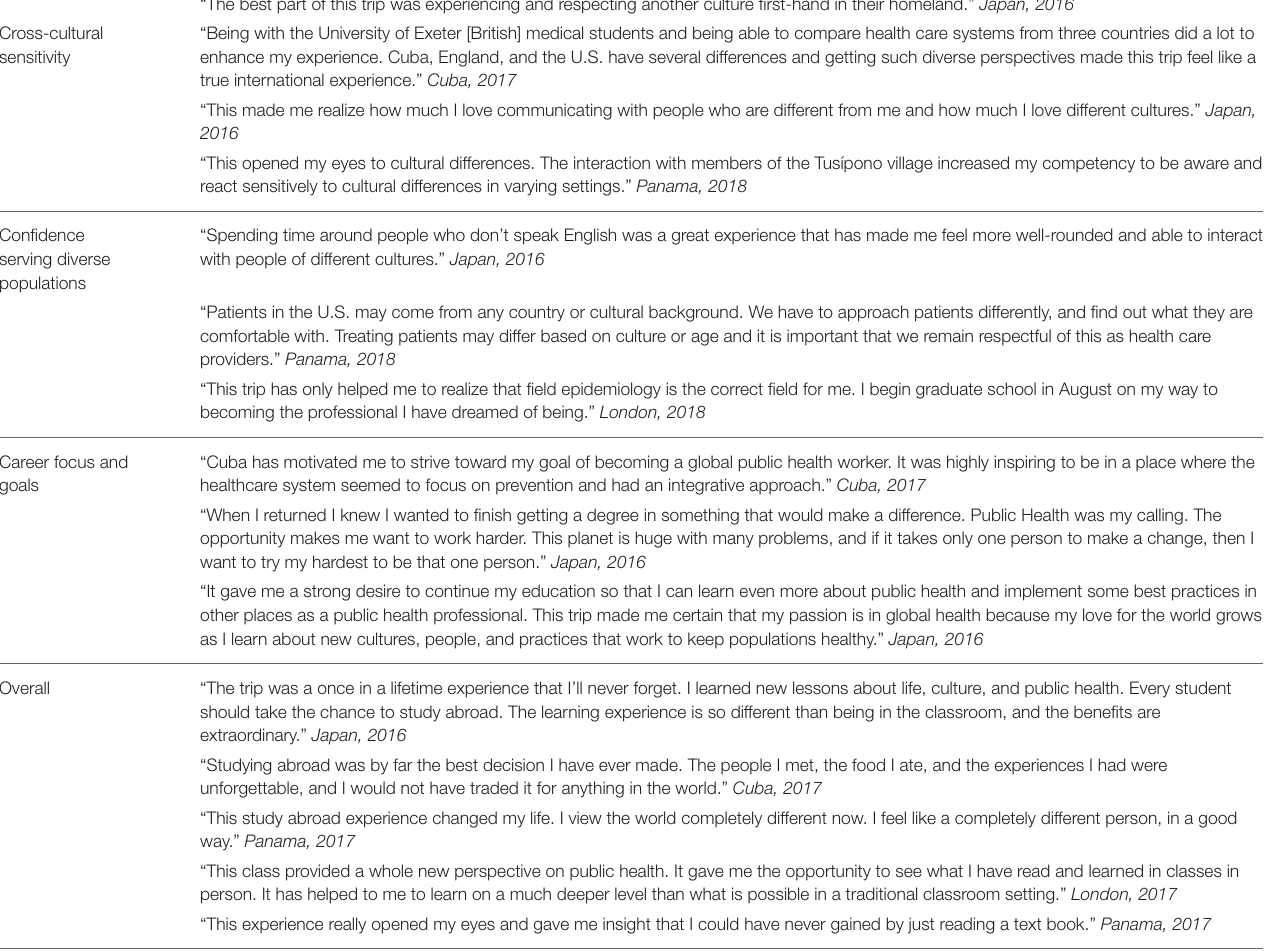
TABLE 3 | Student feedback. “The best part of this trip was experiencing and respecting another culture first-hand in their homeland.” Japan, 2016 Cross-cultural sensitivity true international experience.” Cuba,